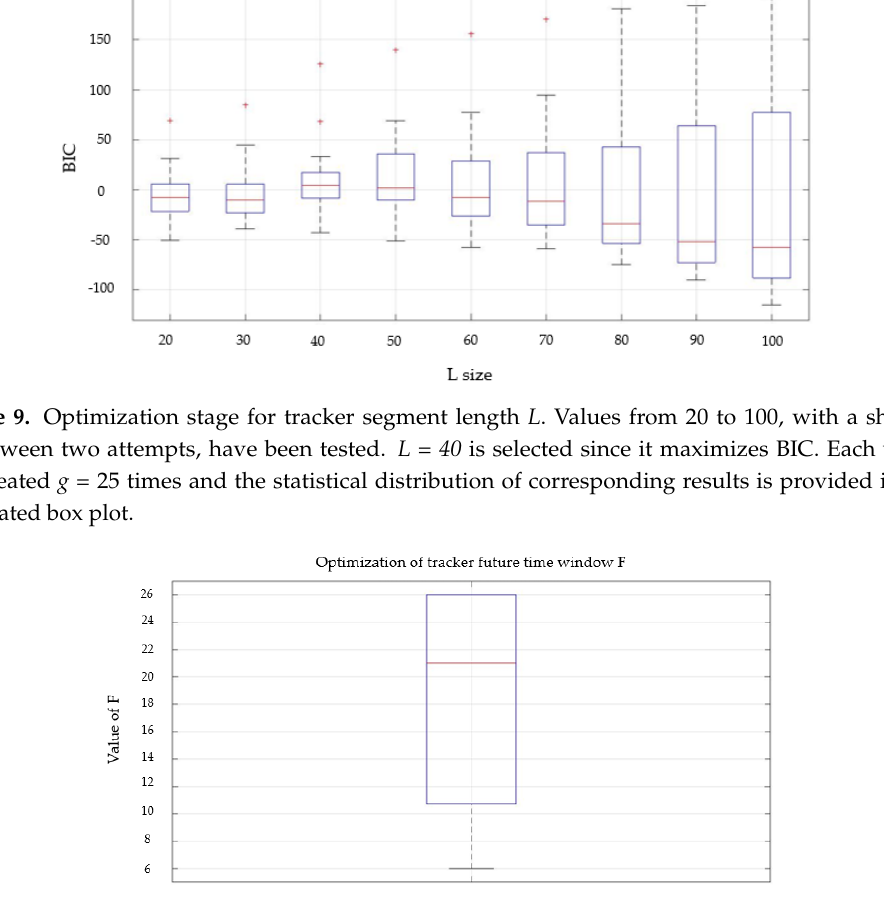
Figure 10. Optimization stage for future window F . g = 25 values of F ensuring PMSE < 10% have been tested. F = 6 (minimum) has been selected to be conservative and to avoid fake alarms.